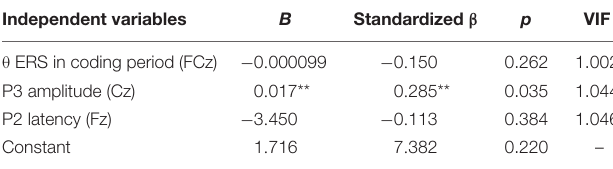
TABLE 7 | Regression parameter of EEG signals to academic